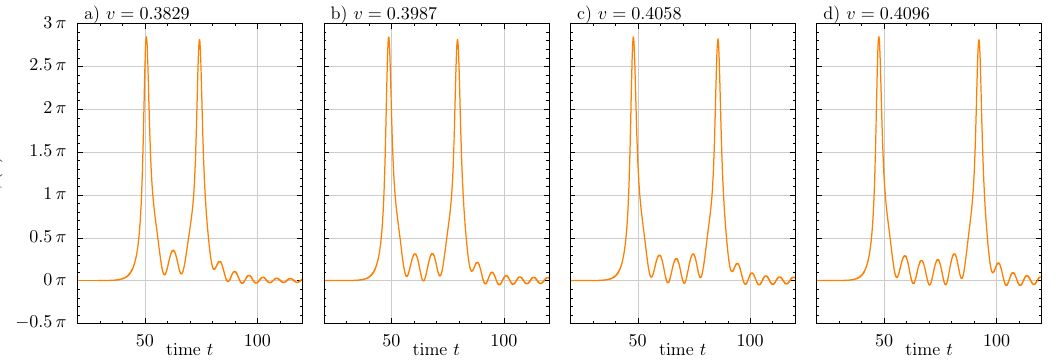
Figure 13 . Field value at the collision centre as a function of time, showing the first four two- bounce resonance windows for (cid:15) = 0 . 6 . For this value of (cid:15) , ω 1 = 0 . 939337 and 2 π/ω 1 = 6 . 68896 . These plots correspond to window numbers n = 3 , 4 , 5 and 6 in the formula